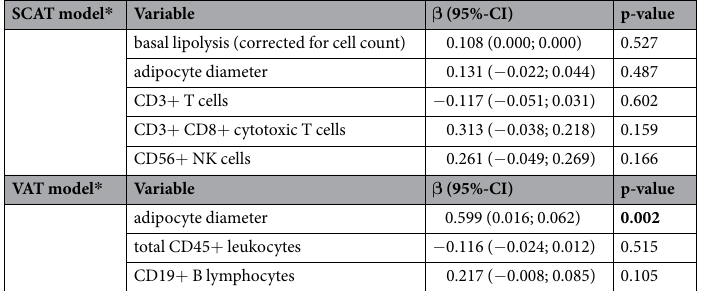
Table 4. Associations between whole-body insulin sensitivity and depot-specific adipose tissue characteristics. * Model adjusted for age and fat mass. Multiple linear regression analyses in lean (n = 18), obese (n = 17) and obese diabetic (n = 8) individuals. The beta of each predictor represents standardized beta along with its respective 95%-CI and